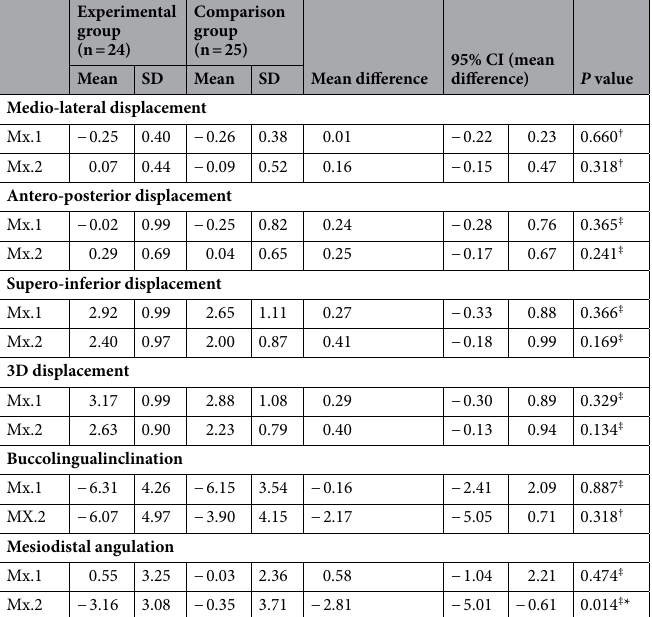
Table 2. 3D Changes using the landmark-based registration on the posterior teeth (TR). † Mann Whitney U test; ‡ t test; SD, Standard deviation; Mx.1, maxillary central incisor; Mx.2, maxillary lateral incisor; (−) values denote medial/posterior/superior displacements, lingual inclination and distal angulations; (+) values denote lateral/anterior/inferior displacements, buccal inclination and mesial angulation. *Statistically significant at P <